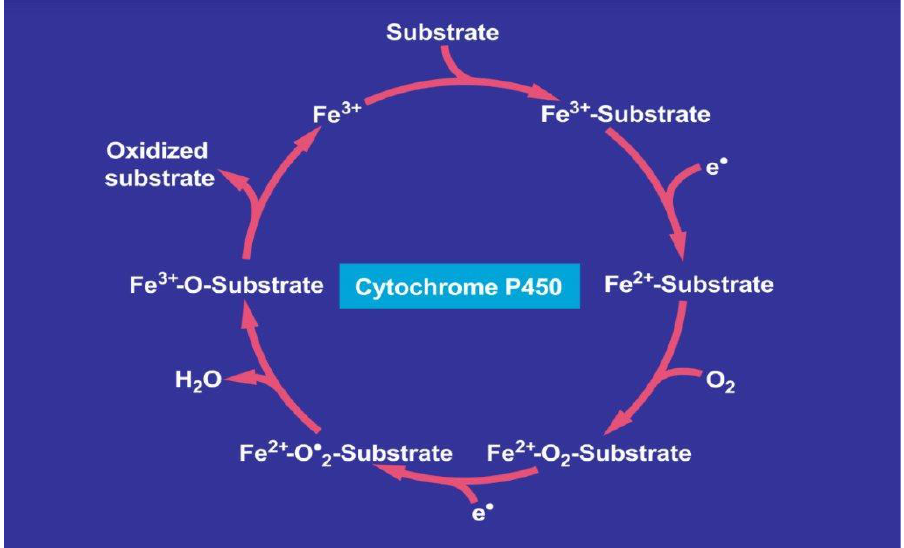
Figure 1. Catalytic CYP cycle of hepatic microsomal drug metabolism. Cytochrome P450 stands for its various isoforms. The term “P450” was proposed to describe a “pigment” with an absorption maximum at 450 nm with the ferrous-carbon monoxide complex of CYP in rat liver microsomes. The figure was adapted from recent open access reports [12,69].